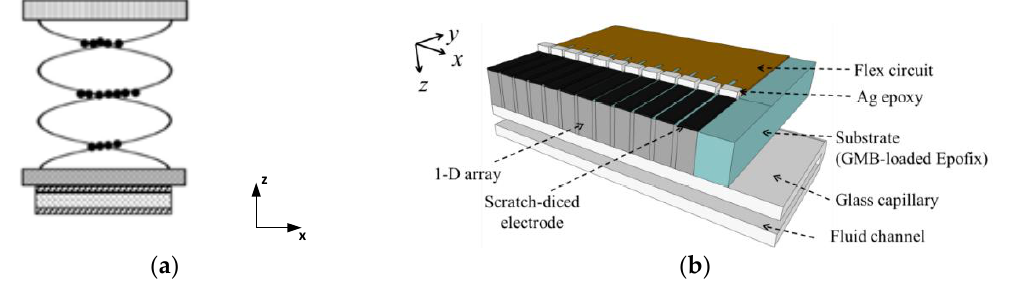
Figure 4. Ultrasonic transducers array by Qiu and Glynne-Jones et al. [14,26,27], Fushimi et al. [62], and Kozuka et al. [15]: ( a ) in the x,z plane, particles can be suspended at the standing wave node formed by resonance between the actuator and the reflector. (This figure is republished reference [27] of Marzo et al. and licensed under CC BY 4.0. Copyright © 2015, Elsevier) ( b ) Structure of a pseudo-one-dimensional acoustic driver array. (This figure is republished reference [27] of Marzo et al. and licensed under CC BY-NC-SA 3.0. Copyright © 2014, The